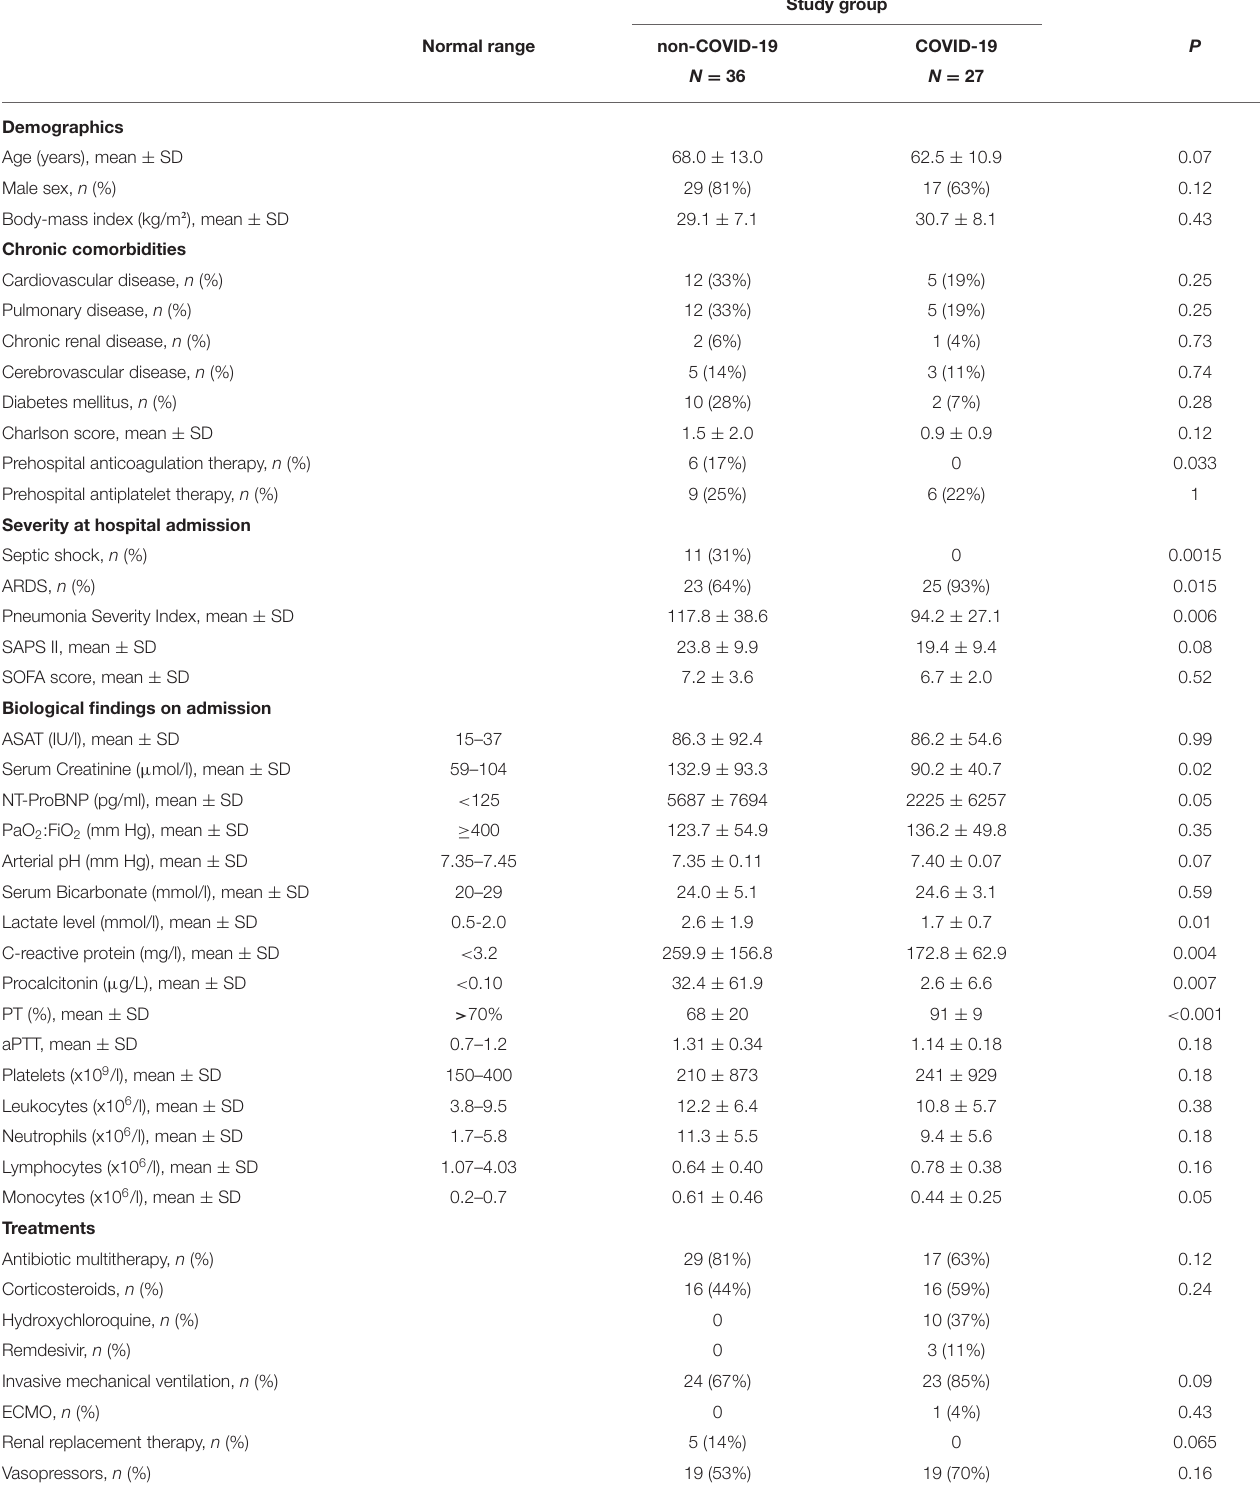
TABLE 1 | Baseline characteristics and outcomes of the study population (LYMPHONIE study,